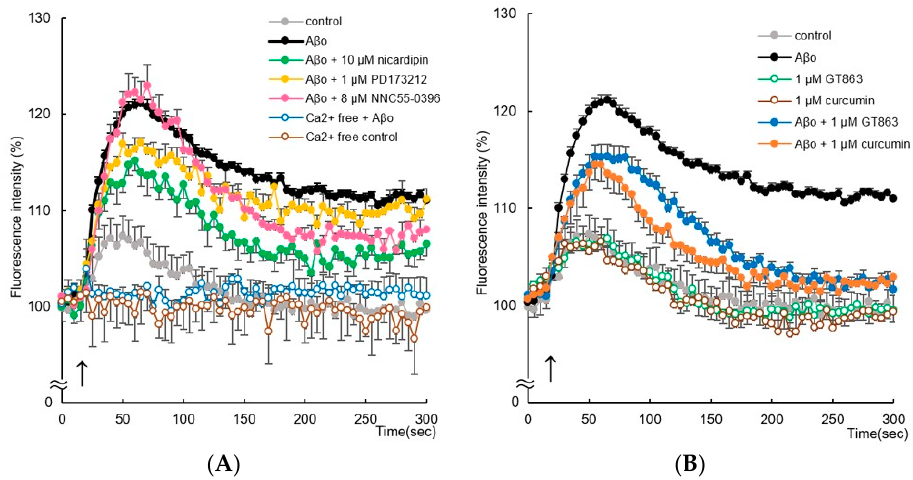
Figure 8. Effect of curcumin and GT863 on intracellular ionized − calcium concentration ([Ca 2+ ]i) in SH − SY5Y cells. ( A ) Changes in [Ca 2+ ]i were measured by the fluorescence intensity of SH − SY5Y cells exposed to 5 μ M A β o and calcium − channel antagonists (10 μ M nicardipine, 1 μ M PD173212, and 8 μ M NNC55 − 0396) for up to 300 min. ( B ) Changes in [Ca 2+ ]I were measured by the fluorescence intensity of SH − SY5Y cells exposed to 5 μ M A β o and treated with curcumin and GT863. The time of administration is indicated by an arrow. The fluorescence intensity was evaluated with the value at onset as 100%. The p − values in ANOVA were 0.0001. Each value expresses the mean ± S.E.M. of at least 3 independent experiments ( n = 6).